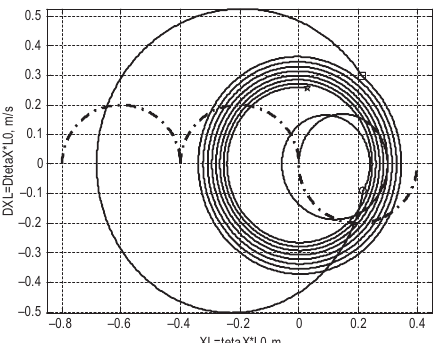
Fig. 7. Phase trajectory of the cargo in respect of the attachment point on the model and switchover phase